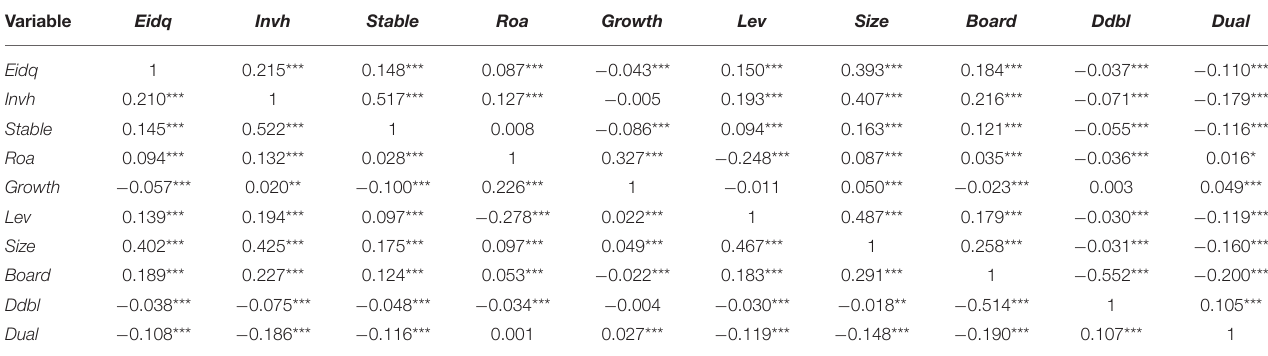
TABLE 4 | Pearson (Spearman) correlation